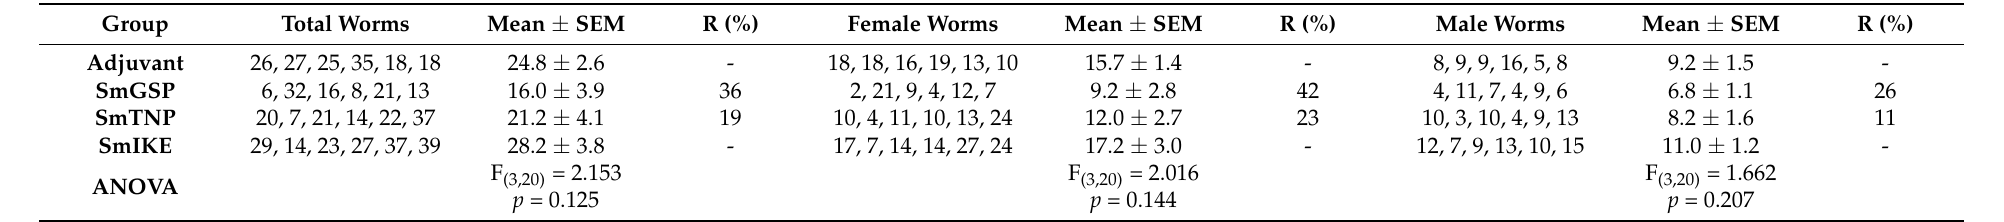
Table 2. Recovery and reduction percentage (R) of total worms, females and males mean and standard error of mean (SEM) in BALB/c mice vaccinated with SmGSP, SmTNP and SmIKE formulated in the ADAD vaccination system, with AA0029 and Quillaja saponaria saponins at eight weeks post- S. mansoni challenge. Statistically significant differences ( p < 0.05) were determined by analysis of variance